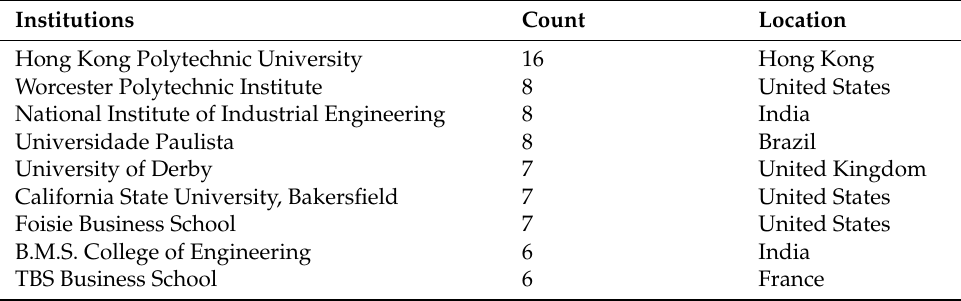
Table 4. Academic institutions with over five